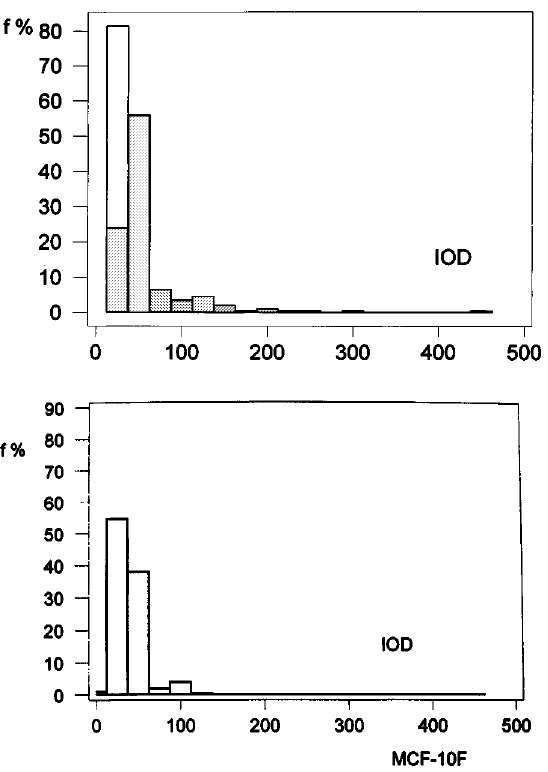
Fig. 1. Relative frequency ( f %) histograms for the Feulgen-DNA content (IOD) of BP1-T ras cells (grey) in comparison with BP1-E1 cells (white) [top]. A histogram for MCF-10F cells is also shown for comparisons ( n = 200) [bottom].